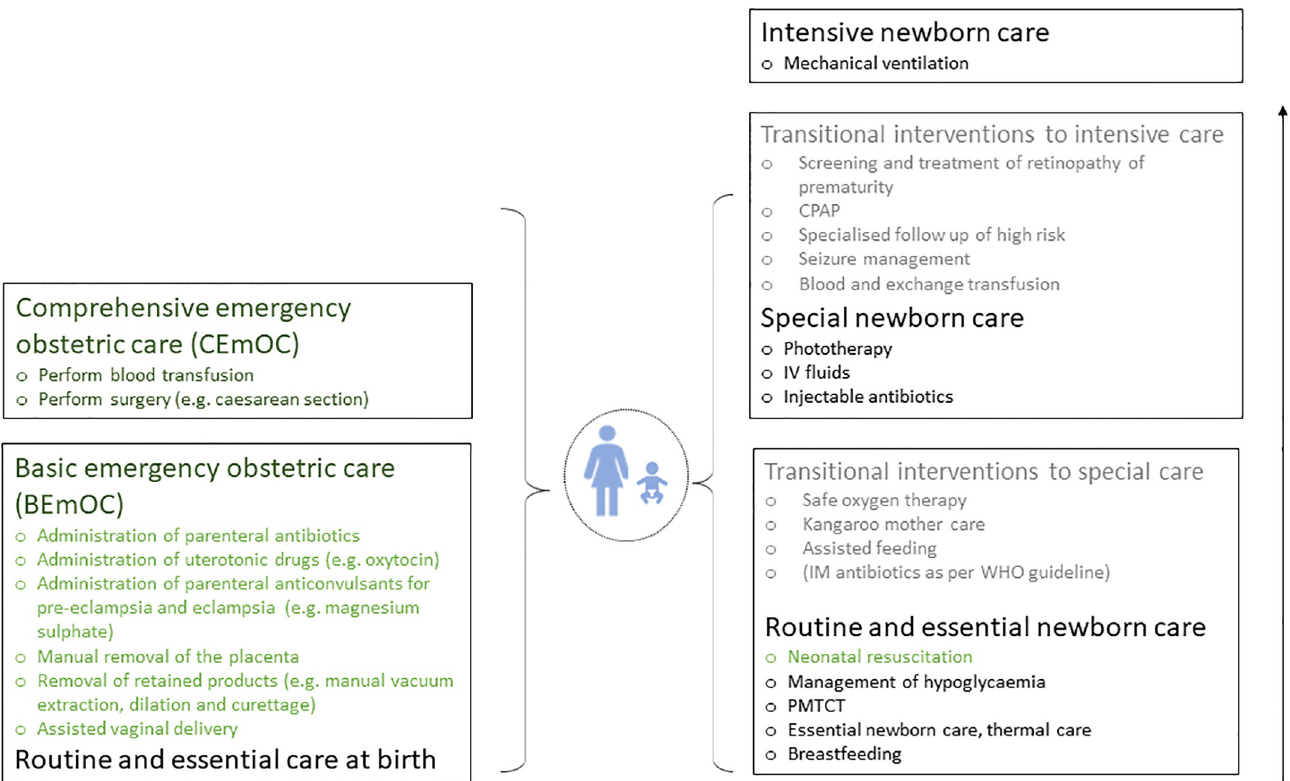
Fig 3. Interventions and levels of inpatient care for small and sick newborns aligned with Emergency Obstetric Care (EmOC) signal functions and levels of care. Green = existing signal function. Grey = transitional interventions. PMTCT = Prevention of mother to child transmission of HIV, IV = intravenous, IM = intramuscular, CPAP = continuous positive airway